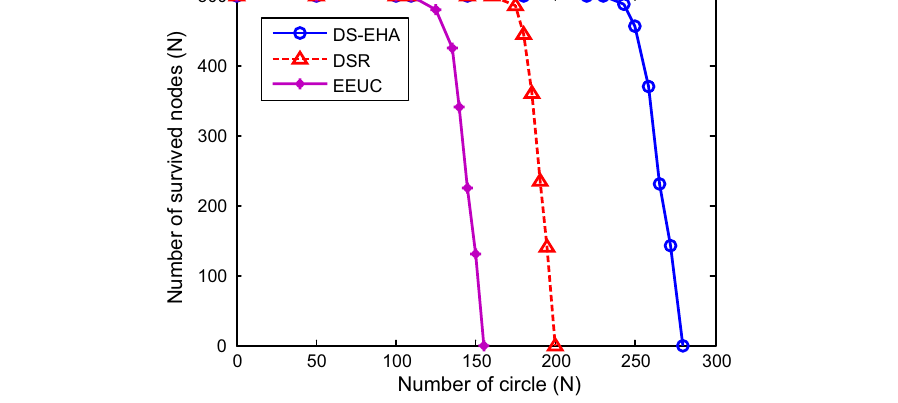
Fig. 8 Number of survived nodes